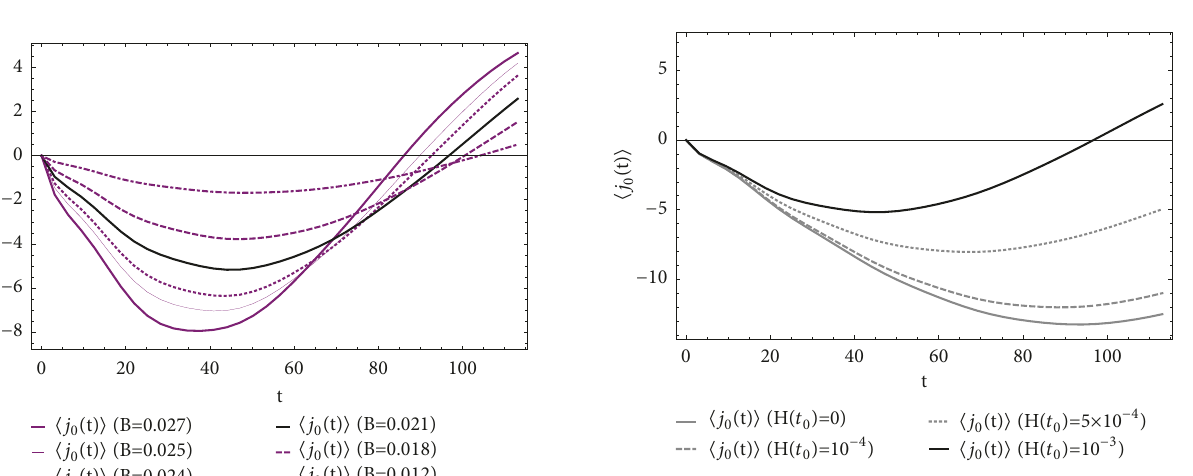
Figure 1: Dependence on temperature 𝑇 of the time evolution of PNA. In horizontal axis, we use the dimensionless time 𝑡 = 𝜔 푟 3, 0 (𝑥 0 − 𝑡 ) where we choose 𝜔 푟 = 0.35 . We fix a set of parameters as 0 3, 0 ,𝜔 0.04,0.05,0.021,10 −3 , 0.0035 ) for all of the ( ̃𝑚 1 , ̃𝑚 2 ,𝐵, 𝐻 푡 3, 0 ) = ( 0 lines. The dotted red, black, dashed red, and red lines show the cases 𝑇 = 50,100,200 , and 400 , respectively.